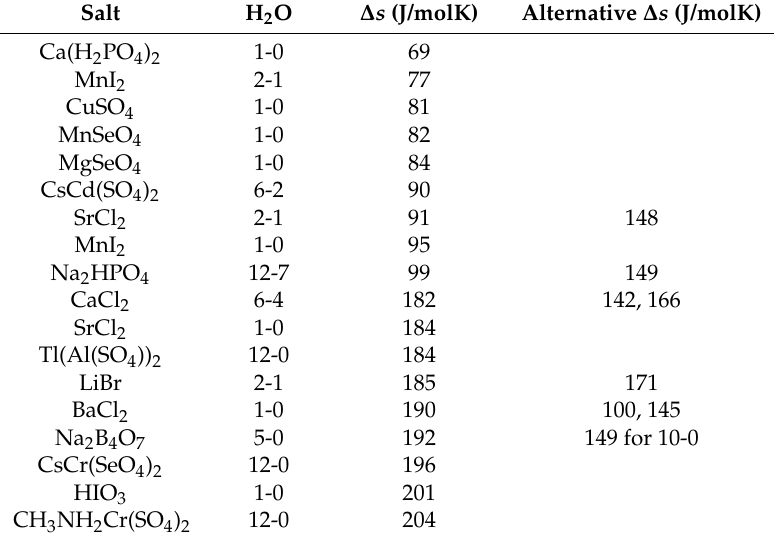
Table 2. Hydration transitions with lowest and highest ∆ s